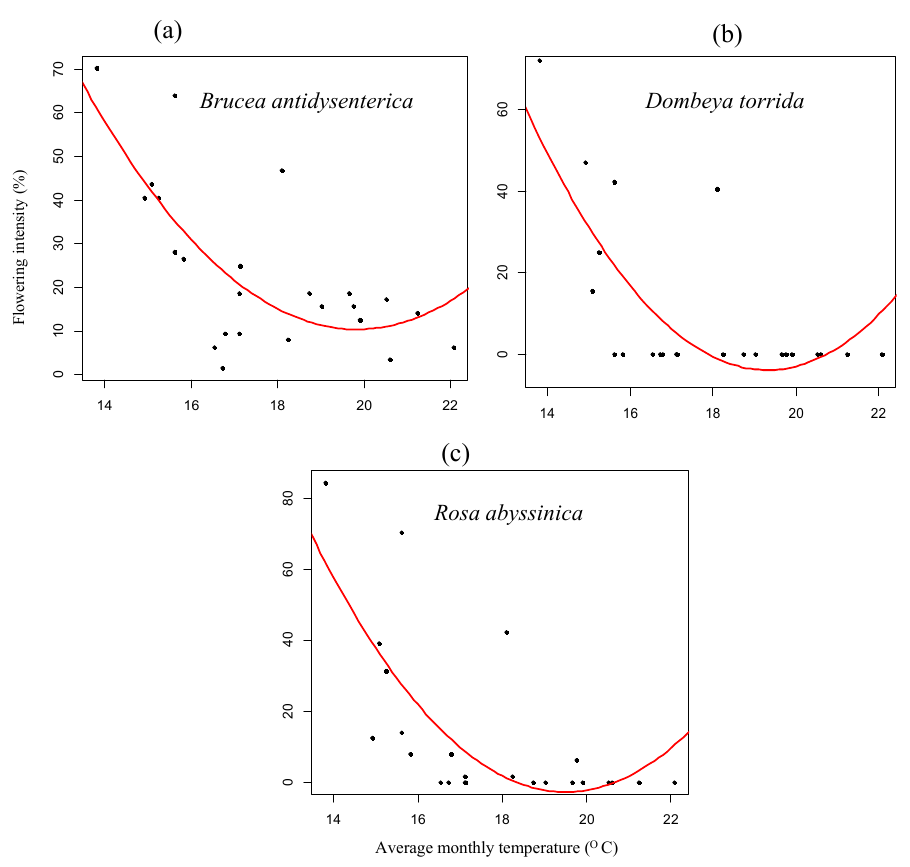
Table 2. The non ‐ linear quadratic polynomial regression model fits showing the effect of average monthly temperature (T) and rainfall (RF) on the flowering percent of tree species.